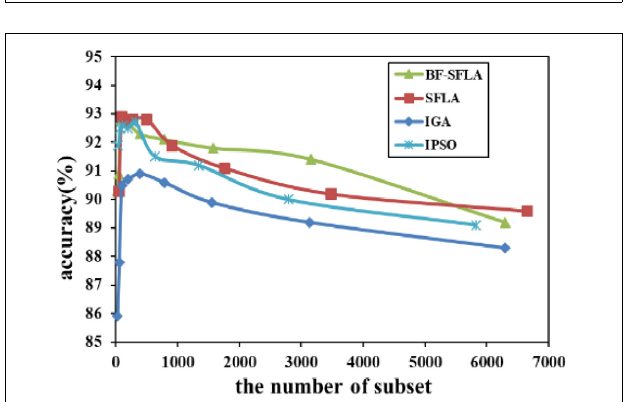
FIGURE 11 | The variation trend of classification accuracy and feature subset of Nervous-System.